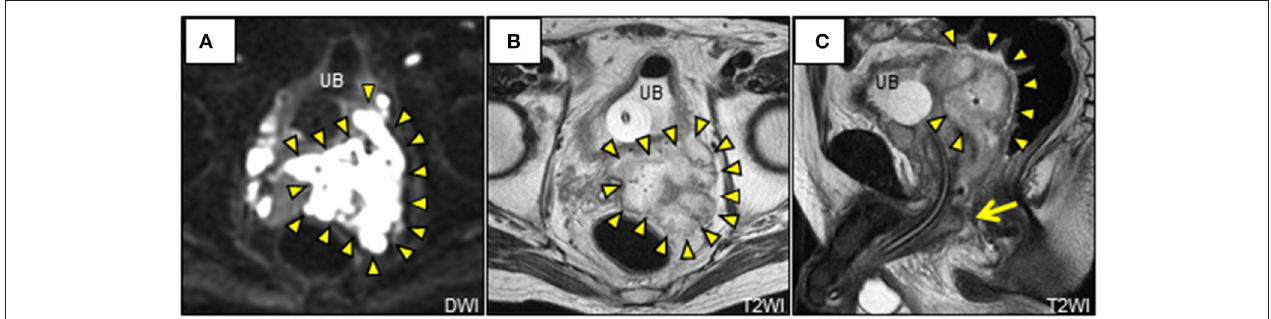
FIGURE 3 | Pelvic magnetic resonance imaging. (A) Axial DWI shows characteristic restricted diffusion on the left lobe of the prostate extending to the opposite lobe and bilateral perivesicular extraperitoneal spaces (arrowheads). (B, C) Axial and sagittal T2WI shows obviously multilocular abscess of both prostate and left seminal vesicle (arrowheads), with a fistulous communication of the bulbar urethra (arrow). DWI, diffusion-weighted image; T2WI, T2-weighted image; UB, urinary